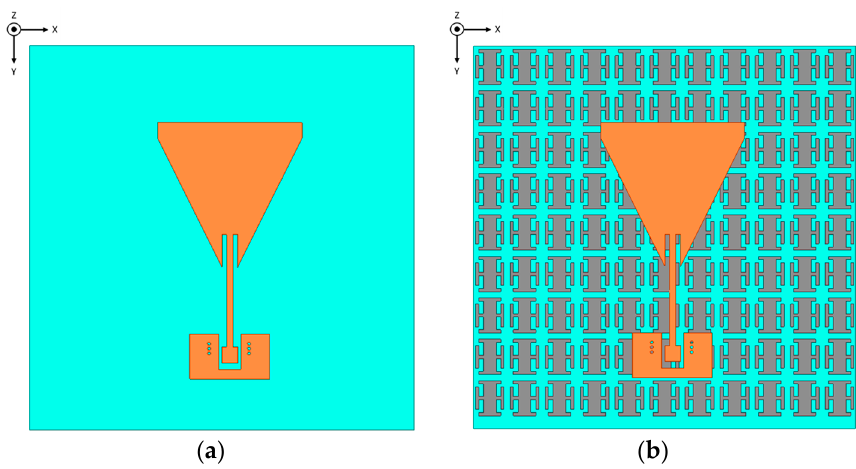
Figure 15. Geometry of the proposed antenna-on-chip: ( a ) Without the M1 layer of AMC; ( b ) With the M1 layer of AMC.